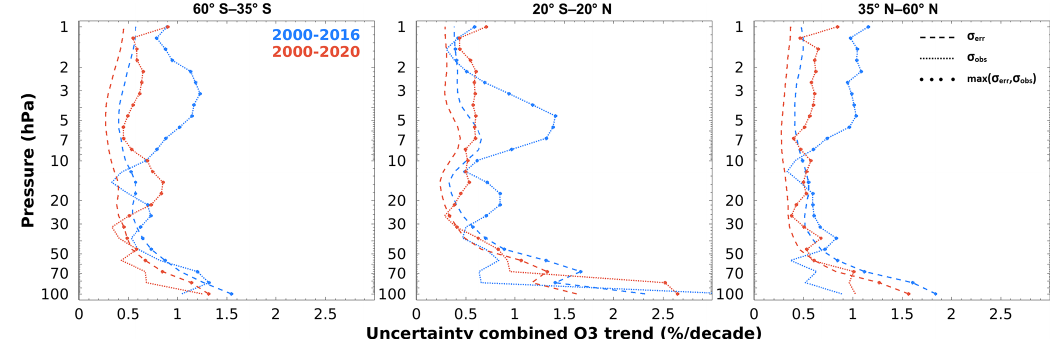
Figure 6. Decomposition of error terms for the combine trend estimates: propagation of errors from fit residuals ( σ err , dashed lines) and standard error of the trend sample ( σ obs , dotted lines) for LOTUS22 in red and LOTUS19 in blue for the three broad latitude bands. Combined trend uncertainty is shown by circle symbols that indicate the maximum of σ err and σ obs in each case.